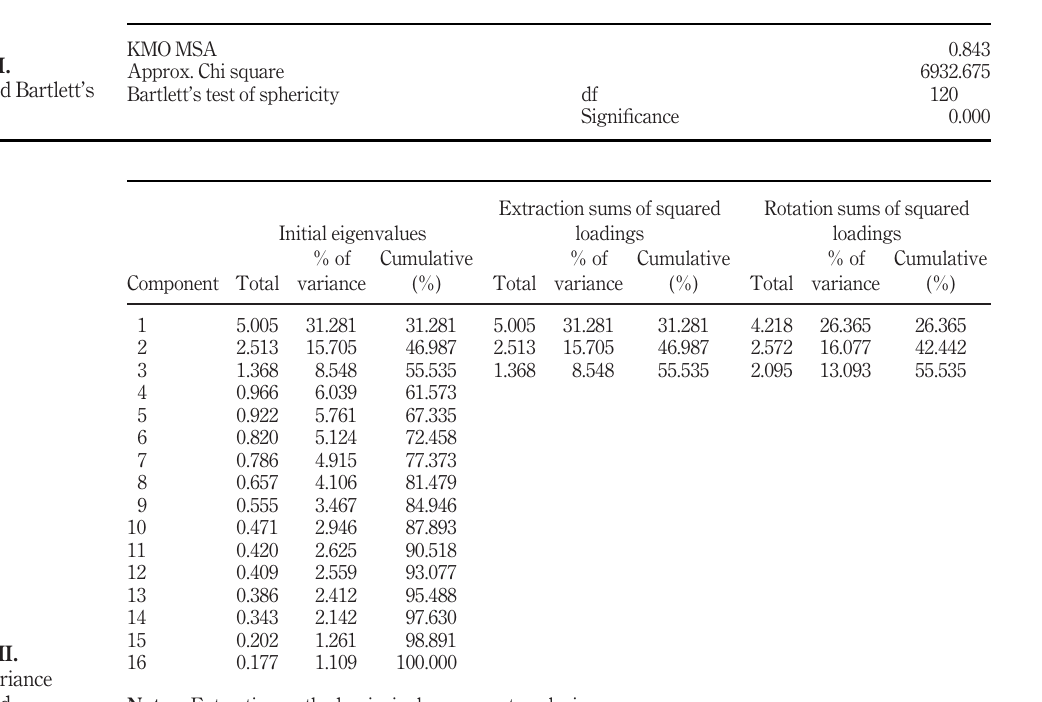
Table III. Total